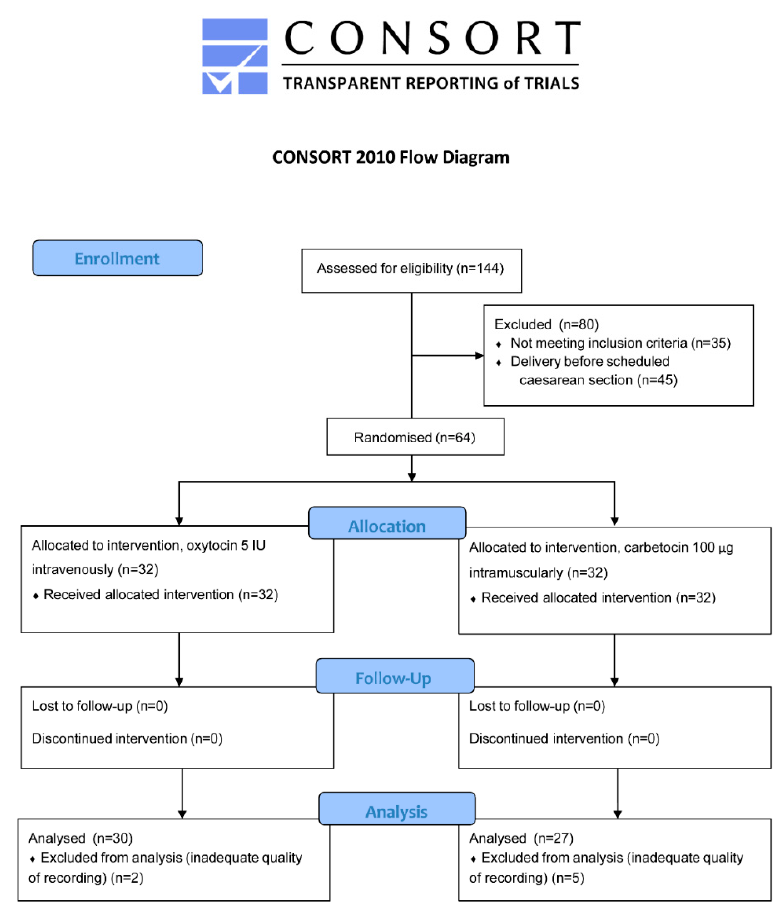
Figure 3. Randomisation and follow-up of study participants.